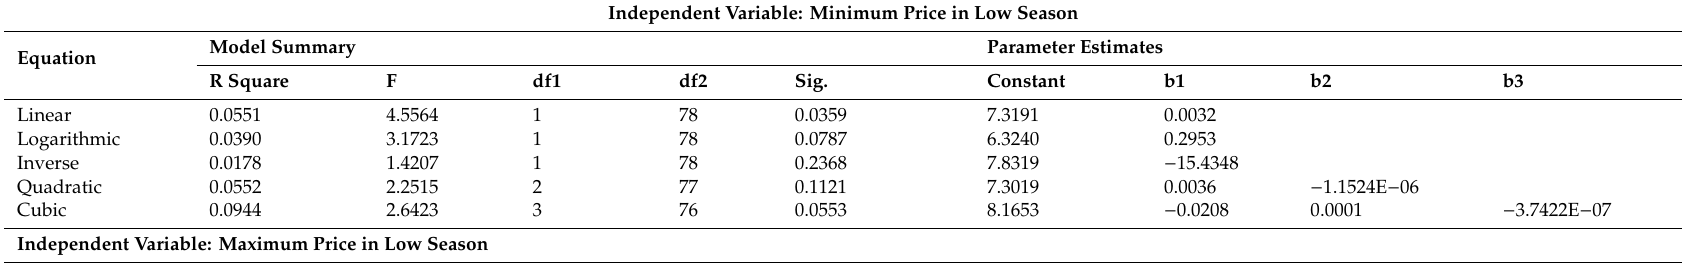
Table 8. Model summary and parameter estimates of regression analysis in Tenerife destination with value as dependent